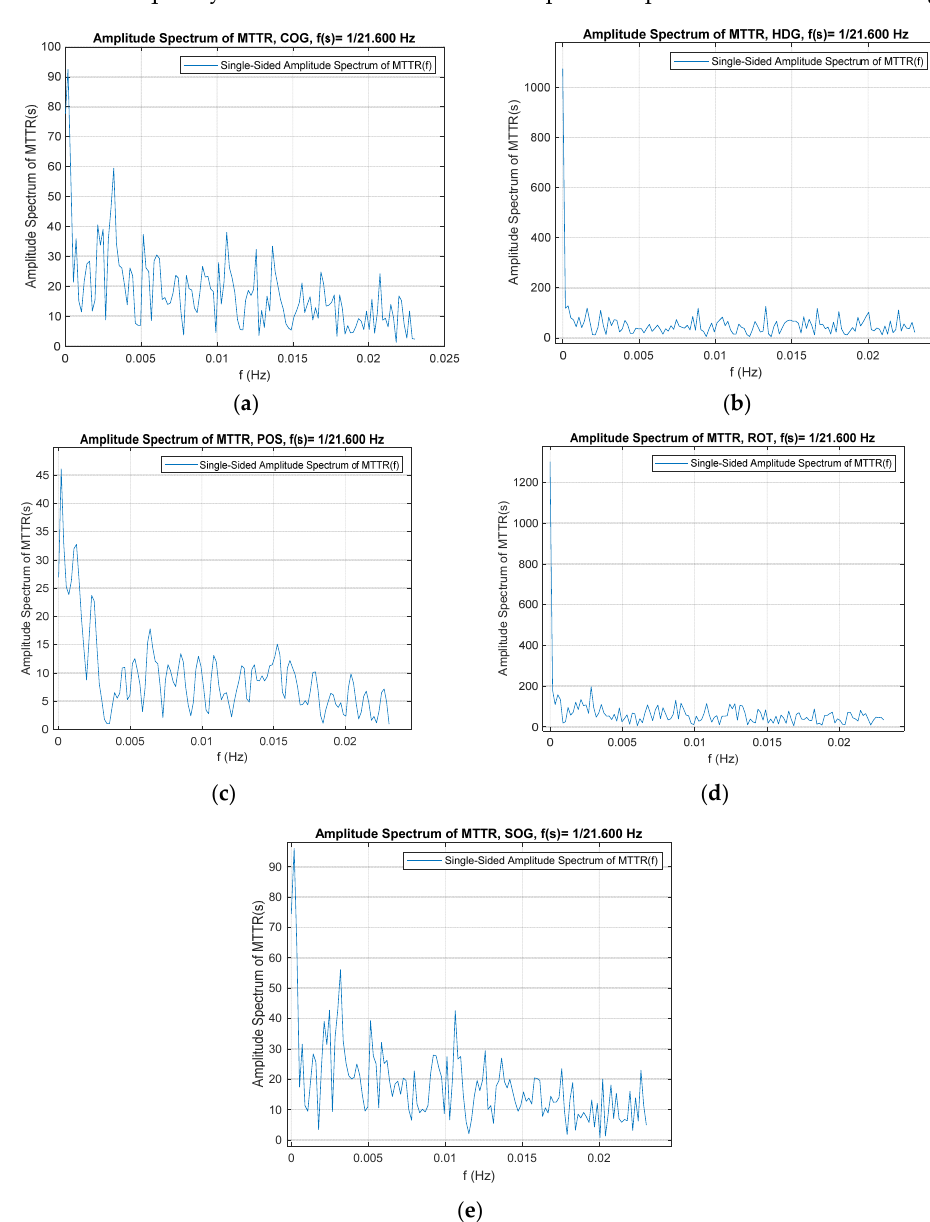
Figure 8. The amplitude spectrum in the frequency domain for MTTR of the AIS service for five navigation parameters ( a ) COG. ( b ) HDG. ( c ) POS. ( d ) ROT. ( e ) SOG.